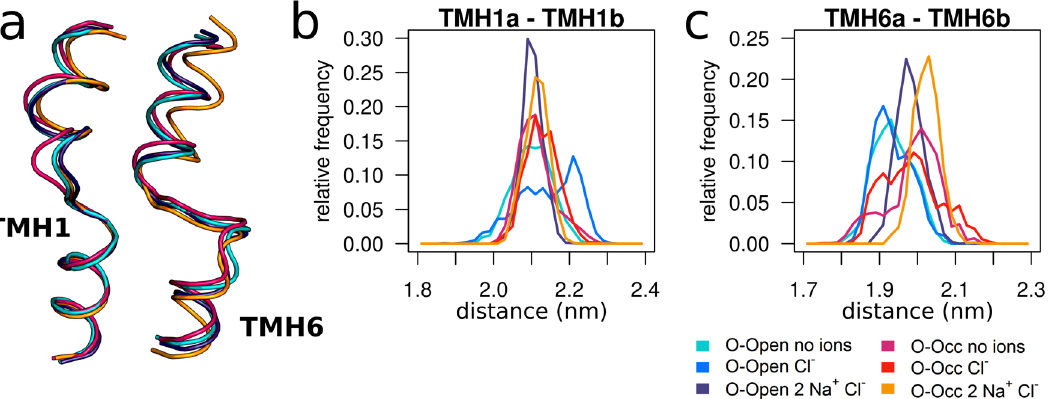
Figure 4. Na + binding constrains the distances from TMH1a to TMH1b and from TMH6a to TMH6b. ( a ) Overlay of TMH1 and TMH6 (fitted to TMH1a and TMH6b) of representative structures. ( b ) Distance distributions of TMH1a (residues 86 –95)–TMH1b (residues 99–111). ( c ) Distance tance distributions of TMH1a (residues 86–95)–TMH1b (residues 99–111). ( c ) Distance distributions of TMH6a (residues 328–338)–TMH6b (residues 343–350). The last 250 ns of 5 parallel simulations with a 1 ns temporal resolution were used for the analysis.